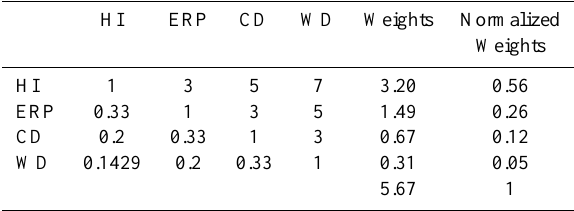
Table 2. Weighting of indices.